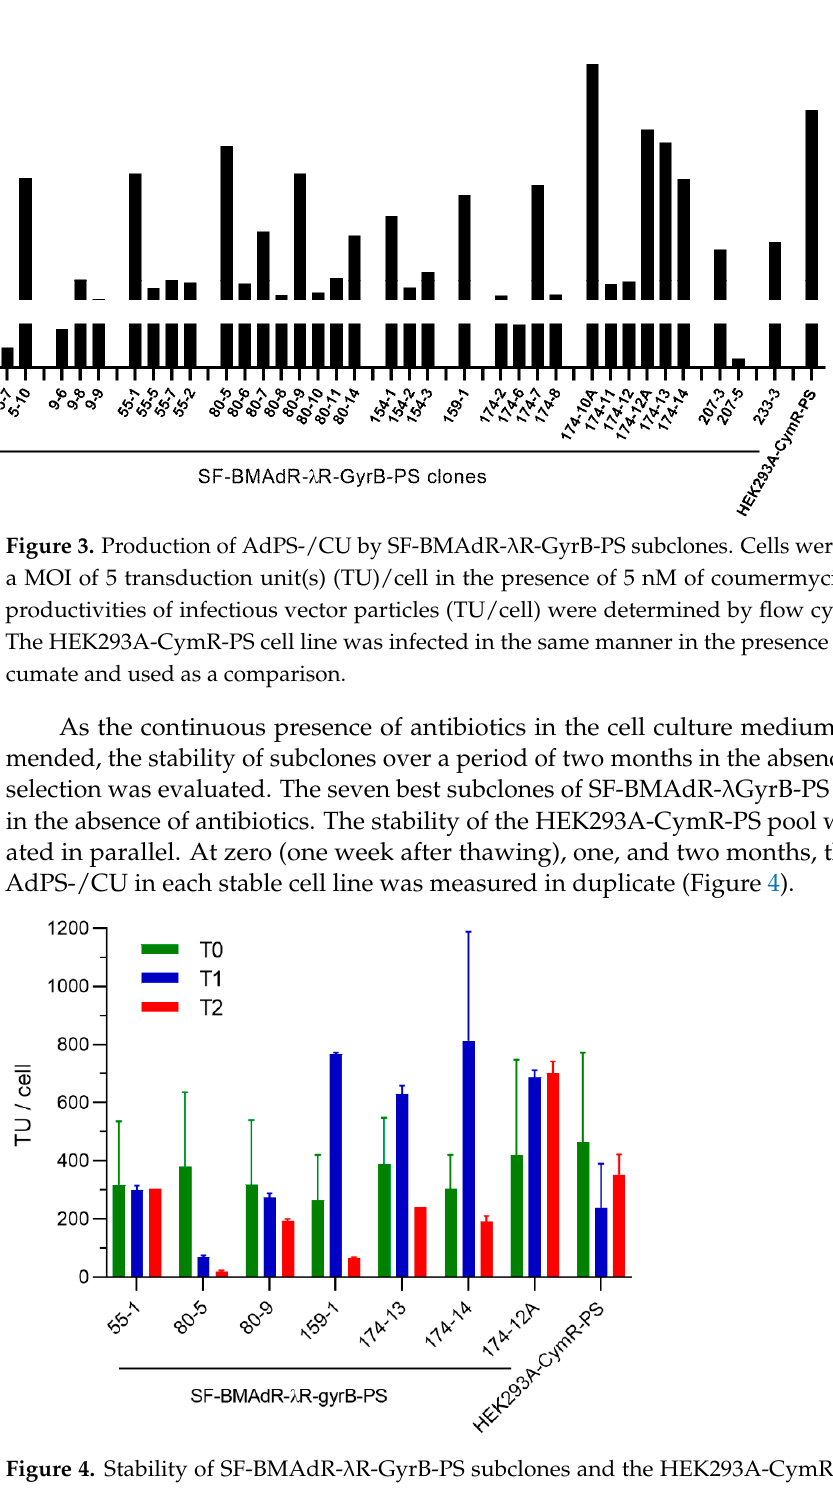
9 of 17 Figure 2. Comparative production of AdPS-/CU by SF-BMAdR- λ R-GyrB-PS clones. Cells were in- fected with AdPS-/CU using a MOI of 5 transduction unit(s) (TU)/cell in the presence of cou- mermycin (5 nM) for SF-BMAdR- λ R-GyrB-PS clones and cumate (50 µg/mL) for HEK293A-CymR- PS pool. The specific productivities of infectious vector particles (TU/cell) were determined by flow cytometry and expressed as TU/cell. The samples with error bars were tested in triplicate ( n = 3) and are presented as mean ± SEM. The samples without error bars were analyzed only once ( n = 1).